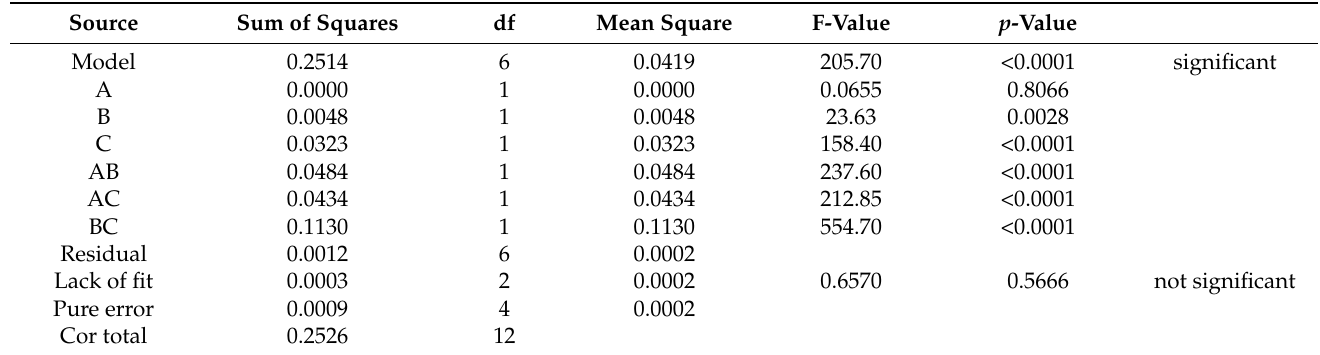
Table 3. Analysis of variance (ANOVA) for the 2FI model of the PI score with a Box–Behnken design (BBD) experiment.